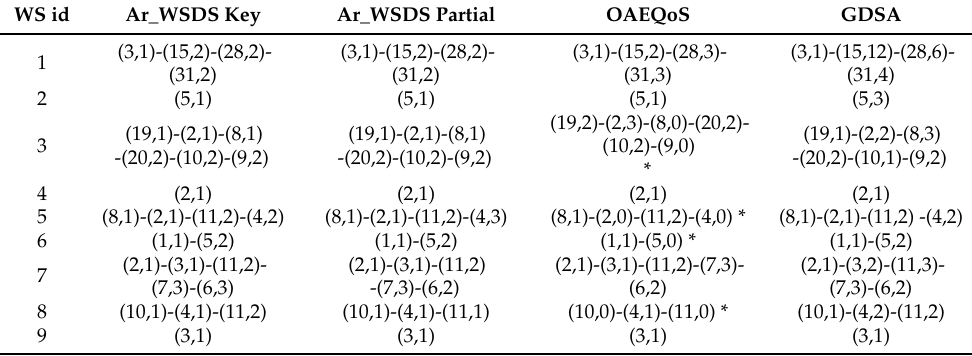
Table A1. Test results of WS